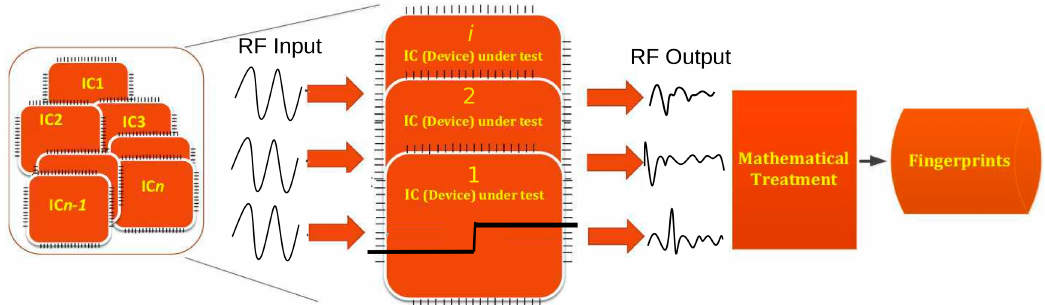
Figure 1. An overview of high level implementation of authentication using guided wave technique. Each Integrated Circuit (IC) taken from the same batch produces distinct radiofrequency (RF) output for the same RF input, which can be post-processed to generate a sort of fingerprint for them.